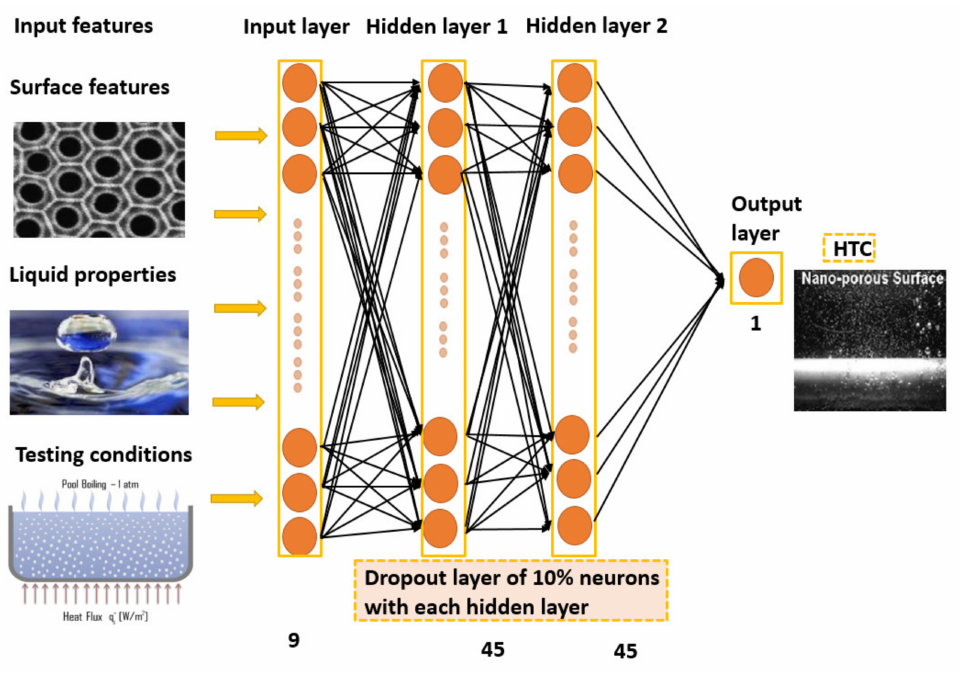
Figure 5. The optimal